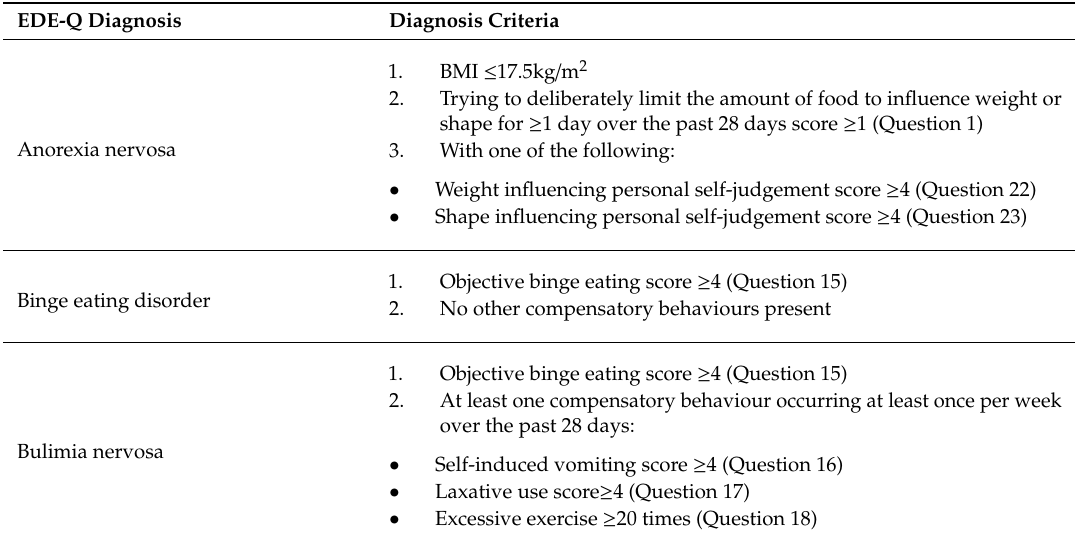
Table A1. Eating disorder and disordered eating diagnosis coding criteria using DSM-4 and 5